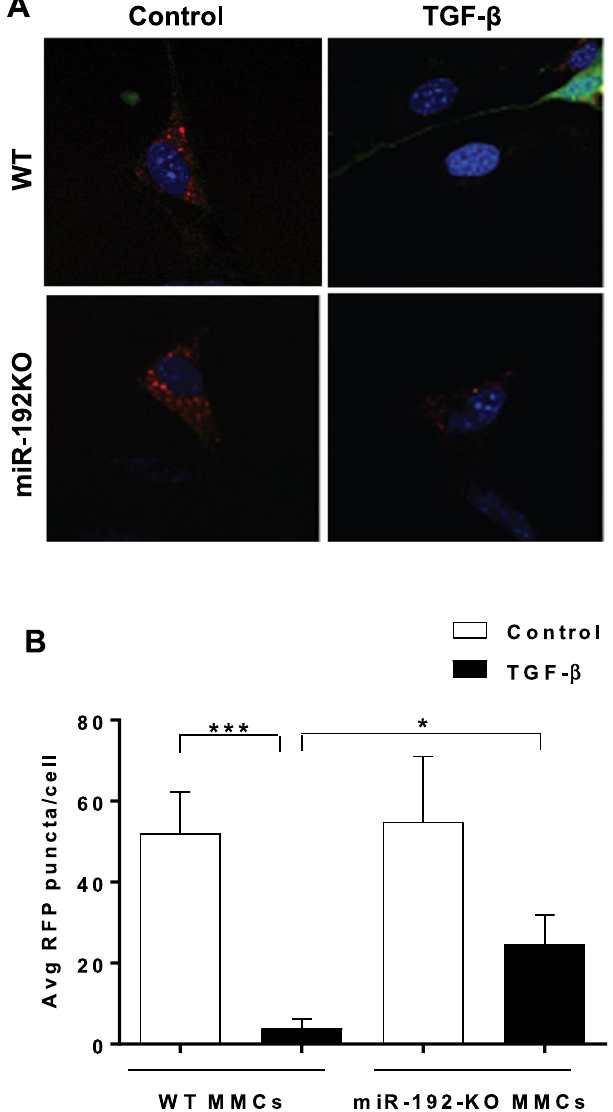
Figure 6. Autophagosome formation is inhibited to a greater extent in WT-MMCs compared to miR-192-KO MMCs following TGF- β treatment. ( A ) Representative confocal microscopy images showing RFP-LC3 puncta in WT or miR-192-KO MMCs transfected with GFP-RFP-LC3 plasmid (1 µ g) followed by TGF- β treatment of these cells for 24 hrs. x1000 (10 × 100 oil) magnification. ( B ) Bar graph showing quantification of RFP-LC3 puncta in WT and miR-192-KO MMCs. * P < 0.05; *** P <